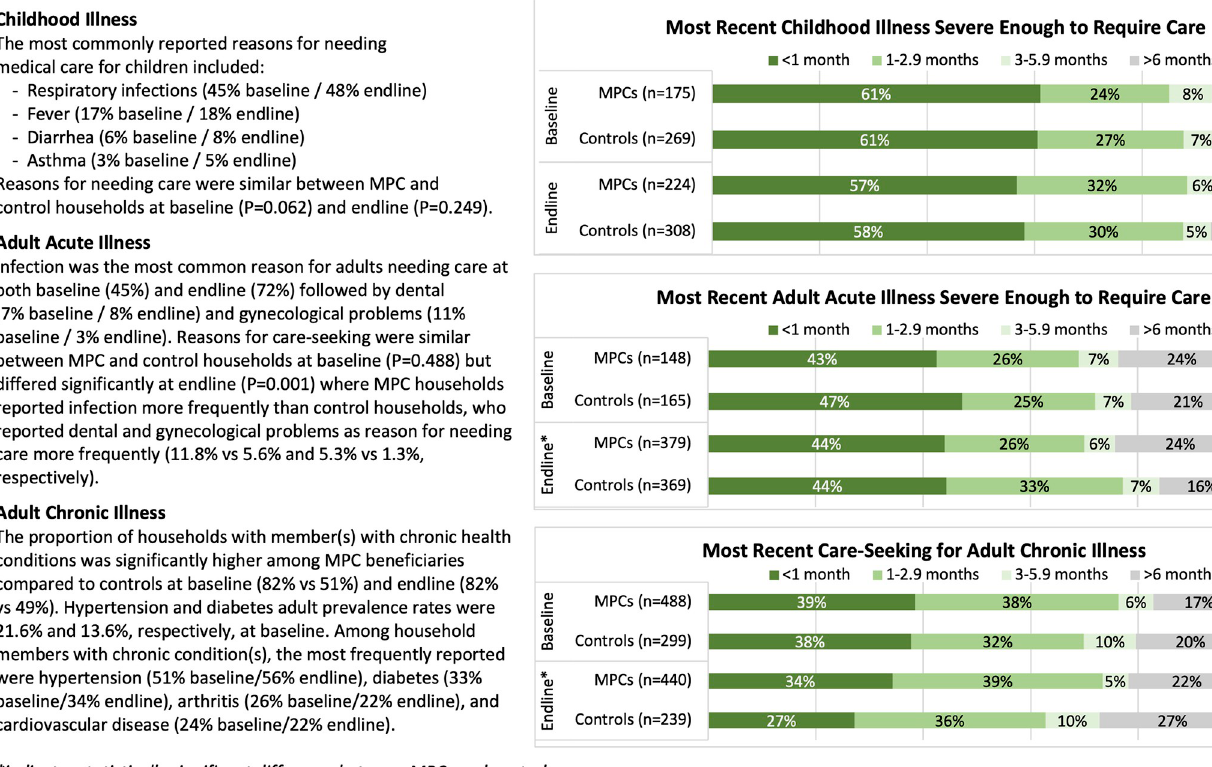
Fig 1. Reasons and timeframes for